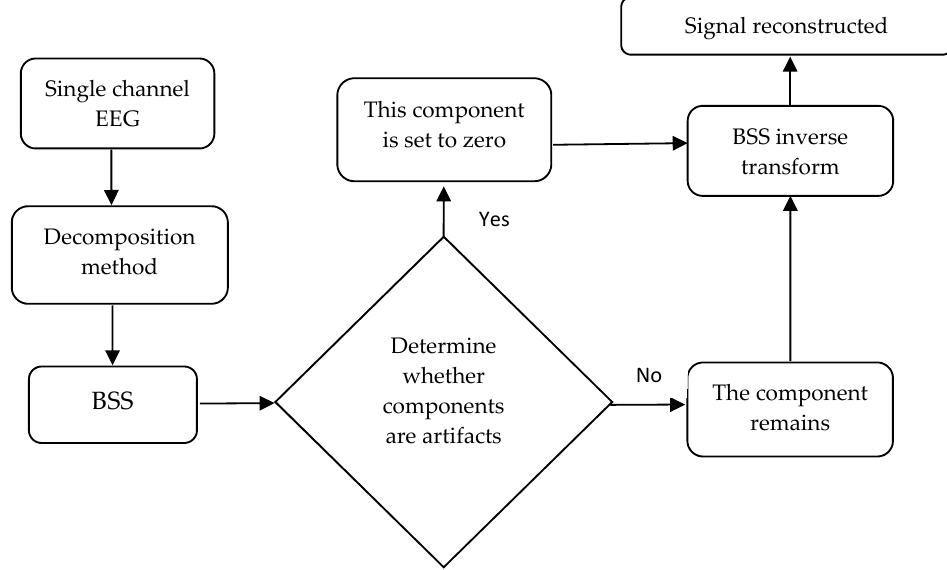
Figure 1. The flow chart of single-channel EEG signal artifact removal.